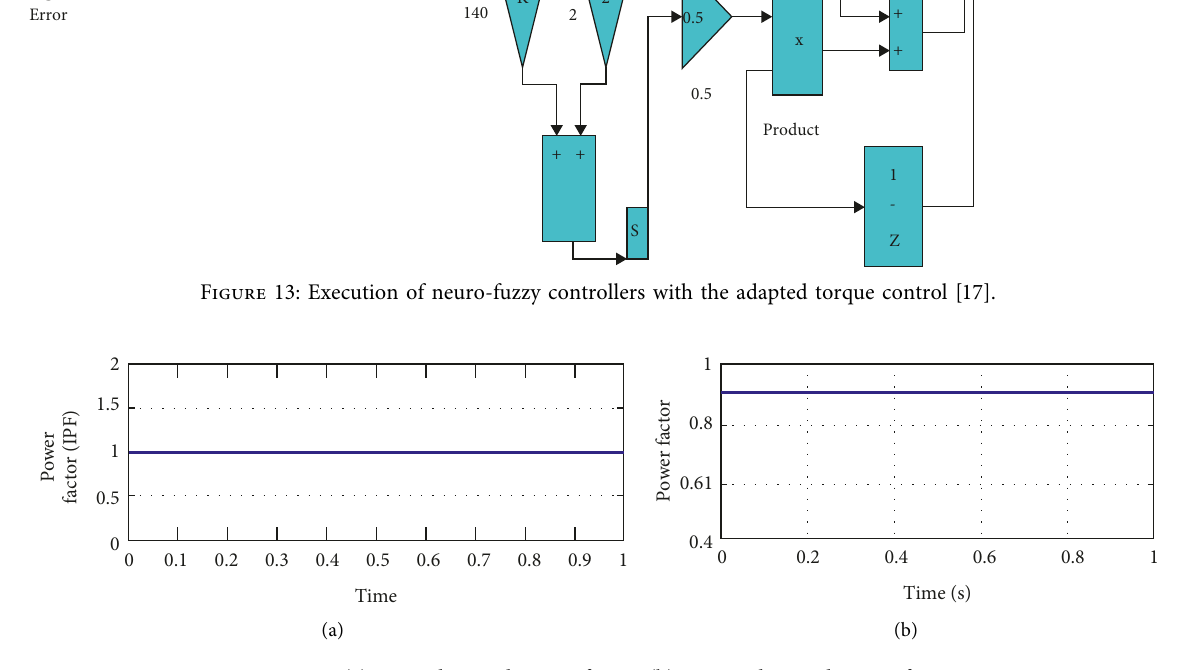
Figure 14: (a) ANN designed power factor. (b) ANFIS designed power factor.